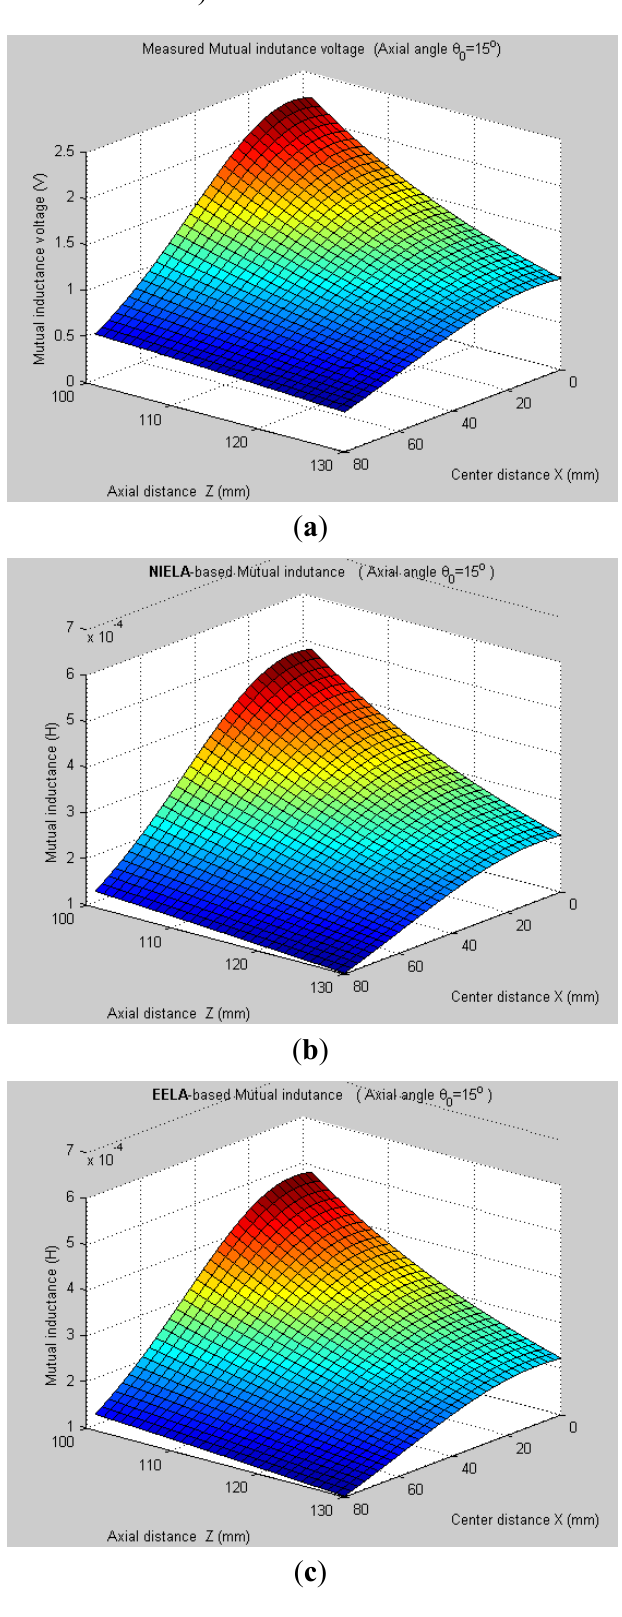
Figure 8. 3-D graphs of ( a ) measured mutual inductance voltage; ( b ) NIELA -based mutual inductance; ( c ) EELA -based mutual inductance versus axial distance and center = 15°, Z = 101–130 distance ( θ 0